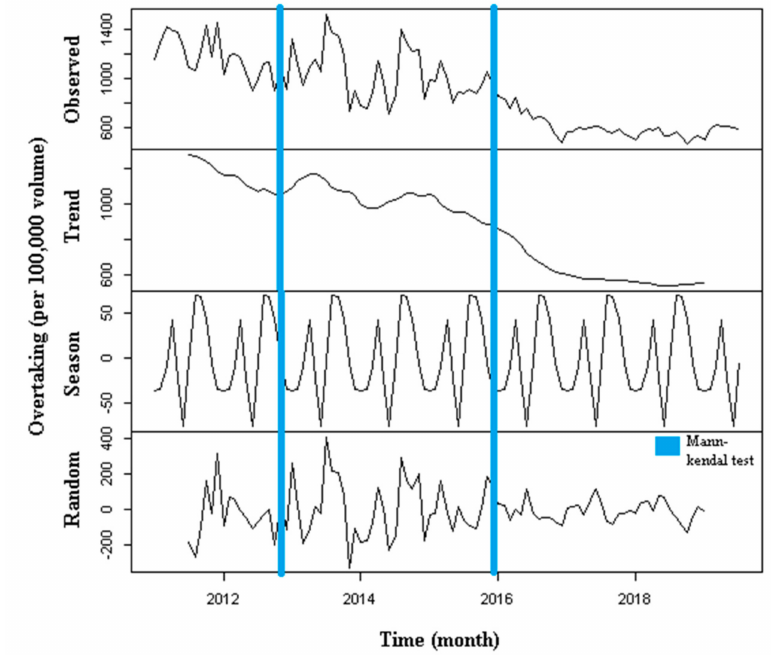
Figure 4. Decomposing the additive time series on a monthly basis for overtaking per 100,000 vehicles in Iran, with blue vertical lines showing the points analyzed with a Mann-Kendall Test, from March 2011 to October 2019.